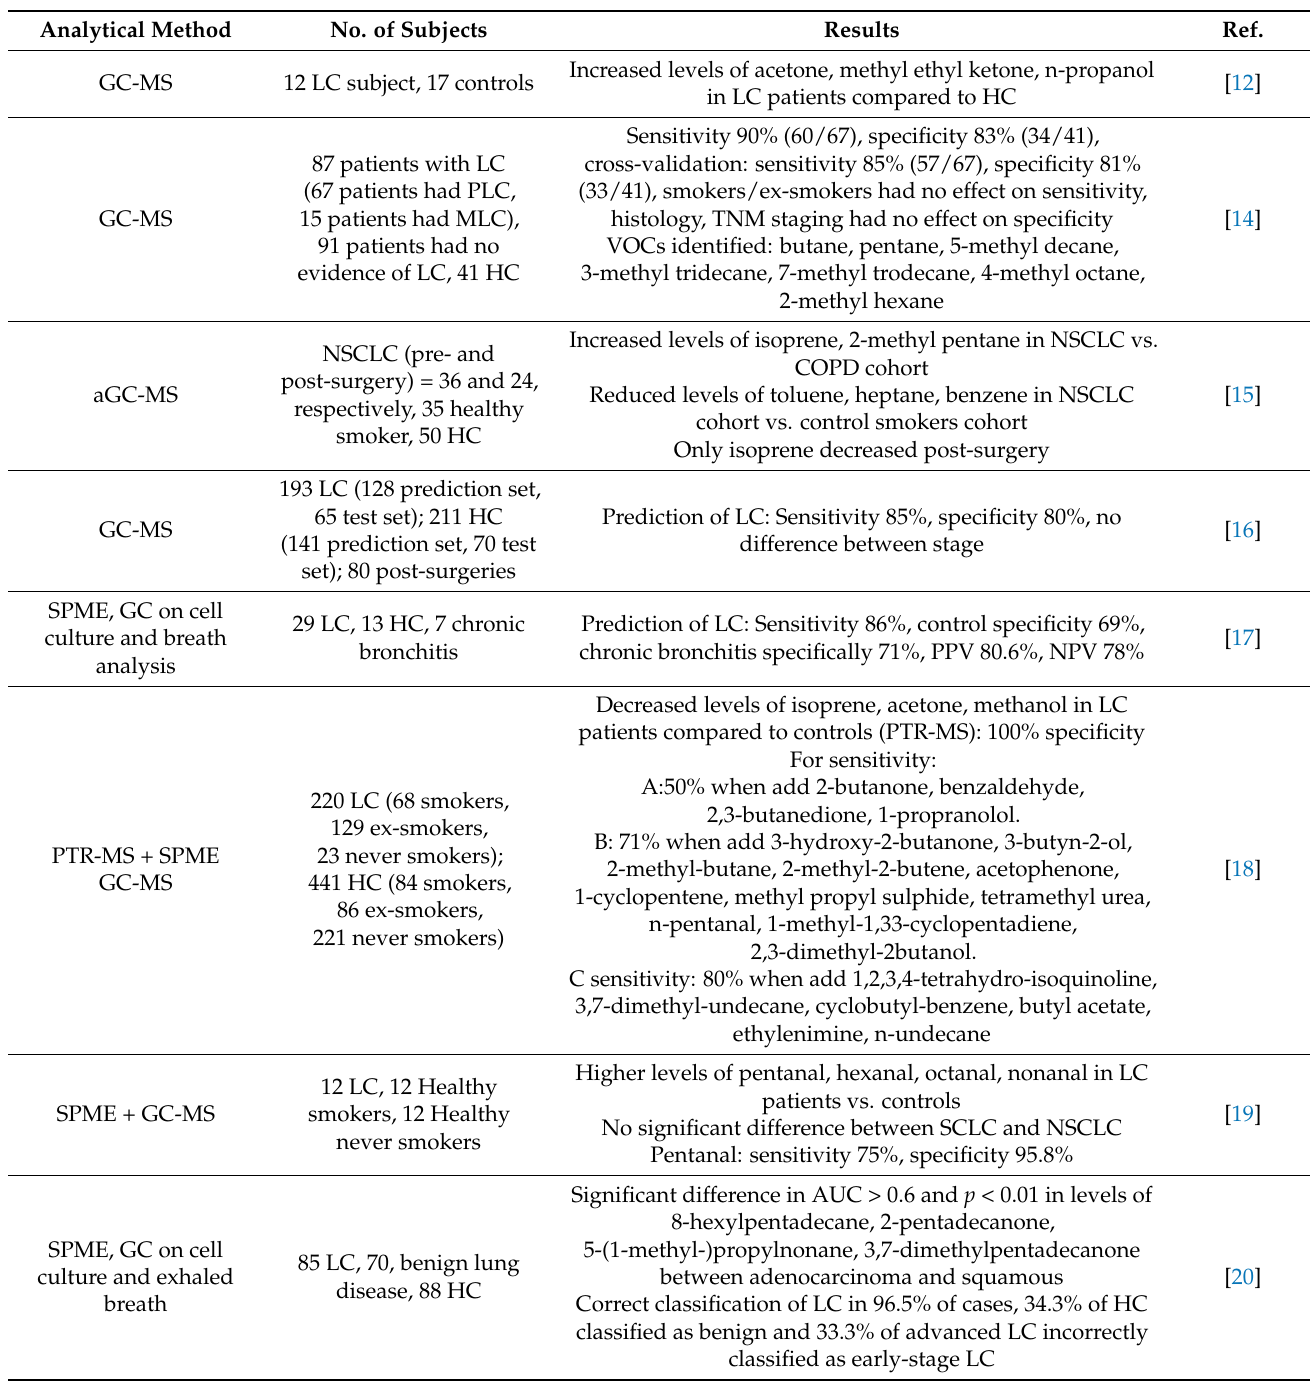
Table 1. Summary of clinical studies using Gas Chromatography/Mass Spectrometry (GC/MS) to explore VOCs in Lung Cancer. Abbreviations: LC: lung cancer; MLC: metastatic lung can- cer; HC: healthy control; TNM: tumor node metastasis classification system; COPD: chronic obstructive pulmonary disease; PPV: positive predictive value; NPV: negative predictive value; PTR-MS: proton-transfer-reaction mass spectrometry; SPME: solid phase microextraction; FT-ICF- MS: Fournier transform-ion cyclotron resonance-mass spectrometry; SCLC: small cell lung cancer; NSCLC: non-small cell lung cancer, CA: cancer; ECC: exhaled carbonyl compounds, UA: upper air- way; DA: distal airway; BPN: benign pulmonary nodules.; MAGIIC: mass abnormalities in gaseous ions and imaging